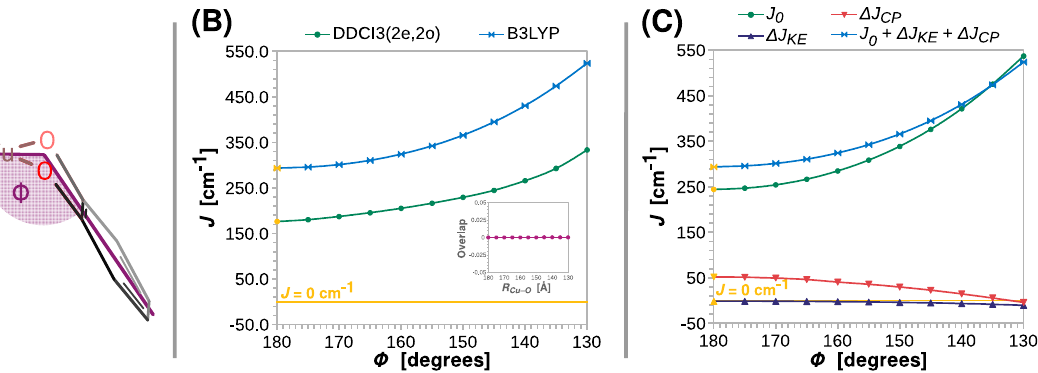
Figure 5. Rigid scan of J along the C–O distance ( R C–O ): schematic representation of the varied structural parameter ( A ); the parameter J predicted at the B3LYP and DDCI3(2e,2o) levels and DDCI3(2e,2o) ( B ); decomposition of J at the B3LYP level ( C ). Inset in ( B ) shows the overlap of the magnetic orbitals calculated at the B3LYP level. All are calculated with the def2-TZVP basis set. For clarity, the line J = 0 cm − 1 is shown as a reference. For the geometry optimized at the B3LYP/def2- TZVP theory level, R C–O = 1.294 Å (labeled with the yellow symbols).